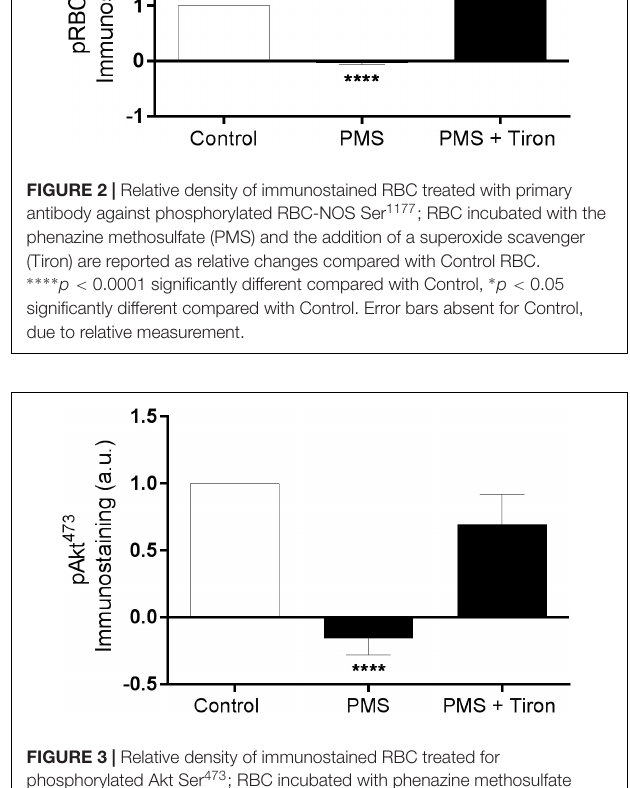
FIGURE 3 | Relative density of immunostained RBC treated for phosphorylated Akt Ser 473 ; RBC incubated with phenazine methosulfate (PMS) and the addition of a superoxide scavenger (Tiron) are reported as relative change compared with Control. ∗∗∗∗ p < 0.0001 significantly different compared with Control. Error bars absent for Control, due to relative